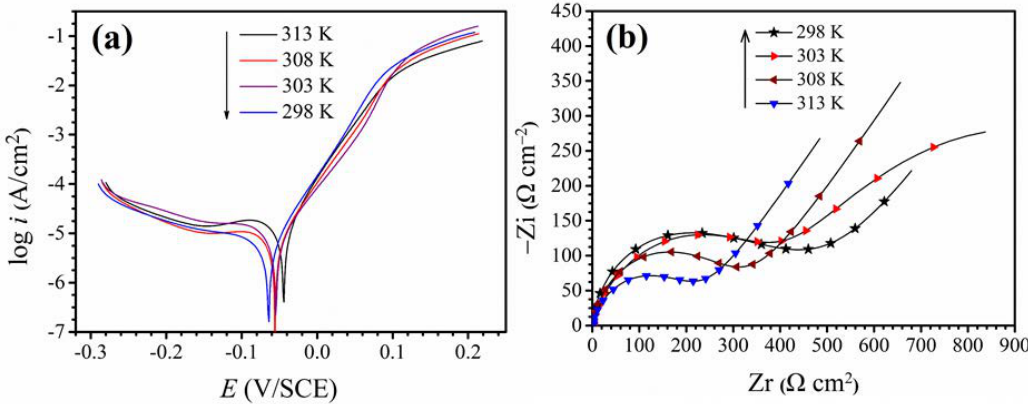
Figure 2. ( a ) The plot of potentiodynamic polarization of copper in 0.5 mol/L H 2 SO 4 without itraconazole and ( b ) the impedance spectra at disparate temperatures.